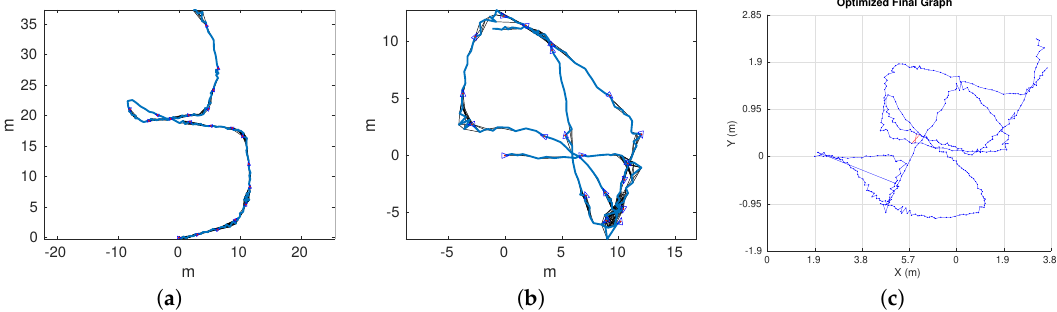
Figure 9. ( a ) Trajectory S 31, ( b ) Trajectory S 32, ( c ) Multi-robot final graph from S 31 and S 32.